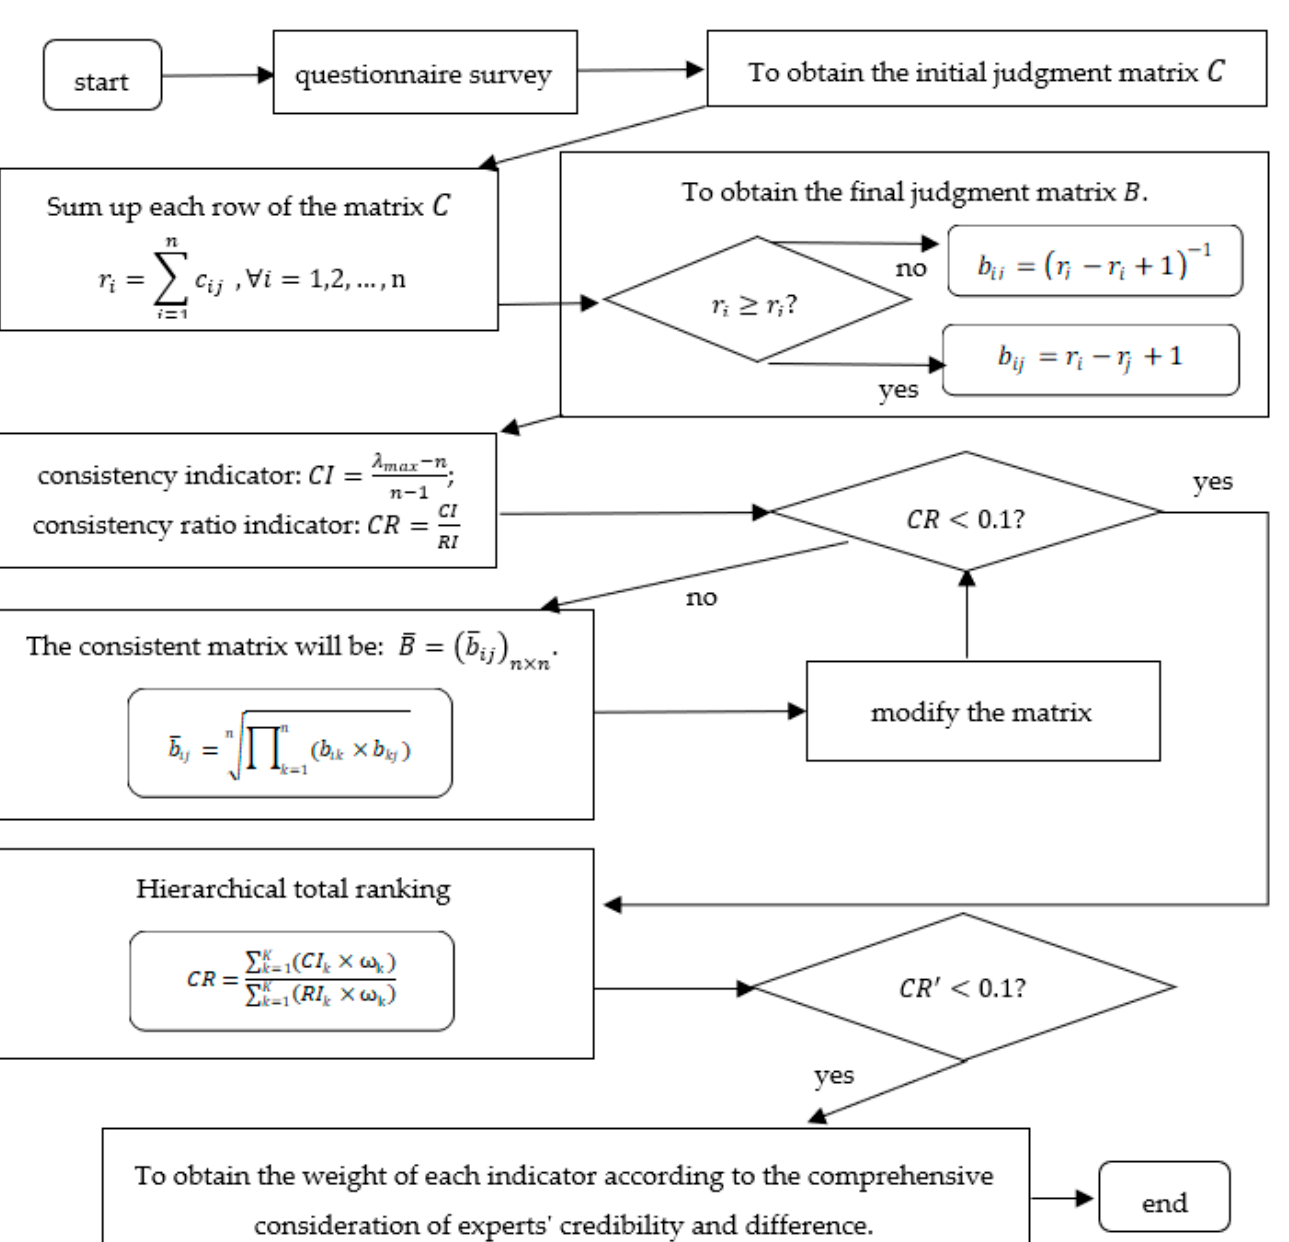
Figure 2. Framework of the calculation model for indicator weights.